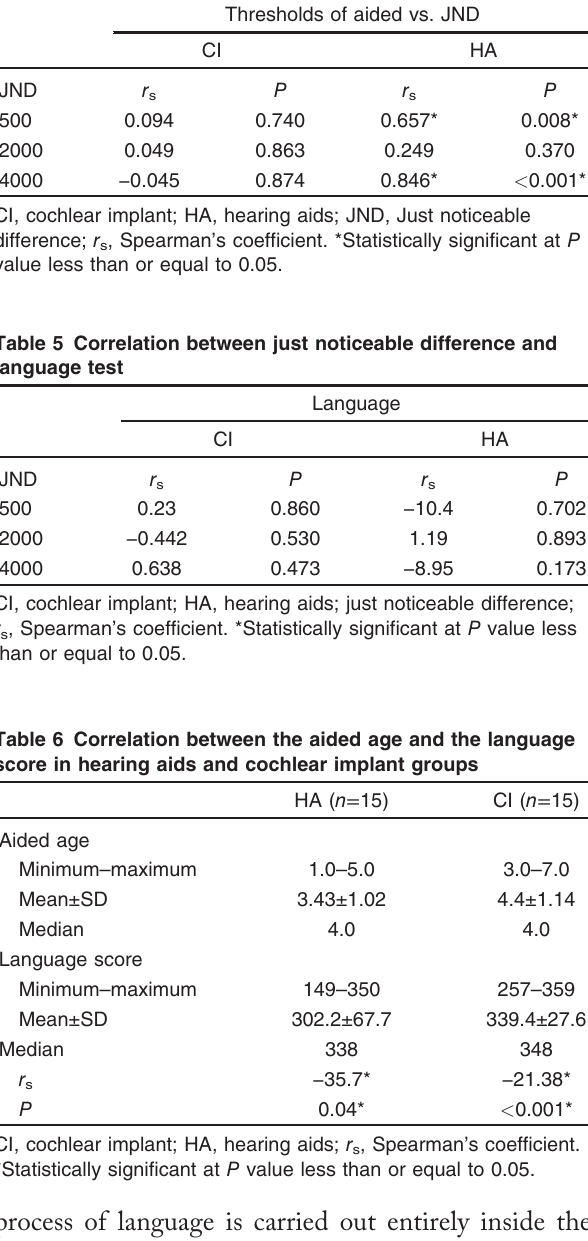
Table 4 Correlation between just noticeable difference and aided thresholds Thresholds of aided vs. JND